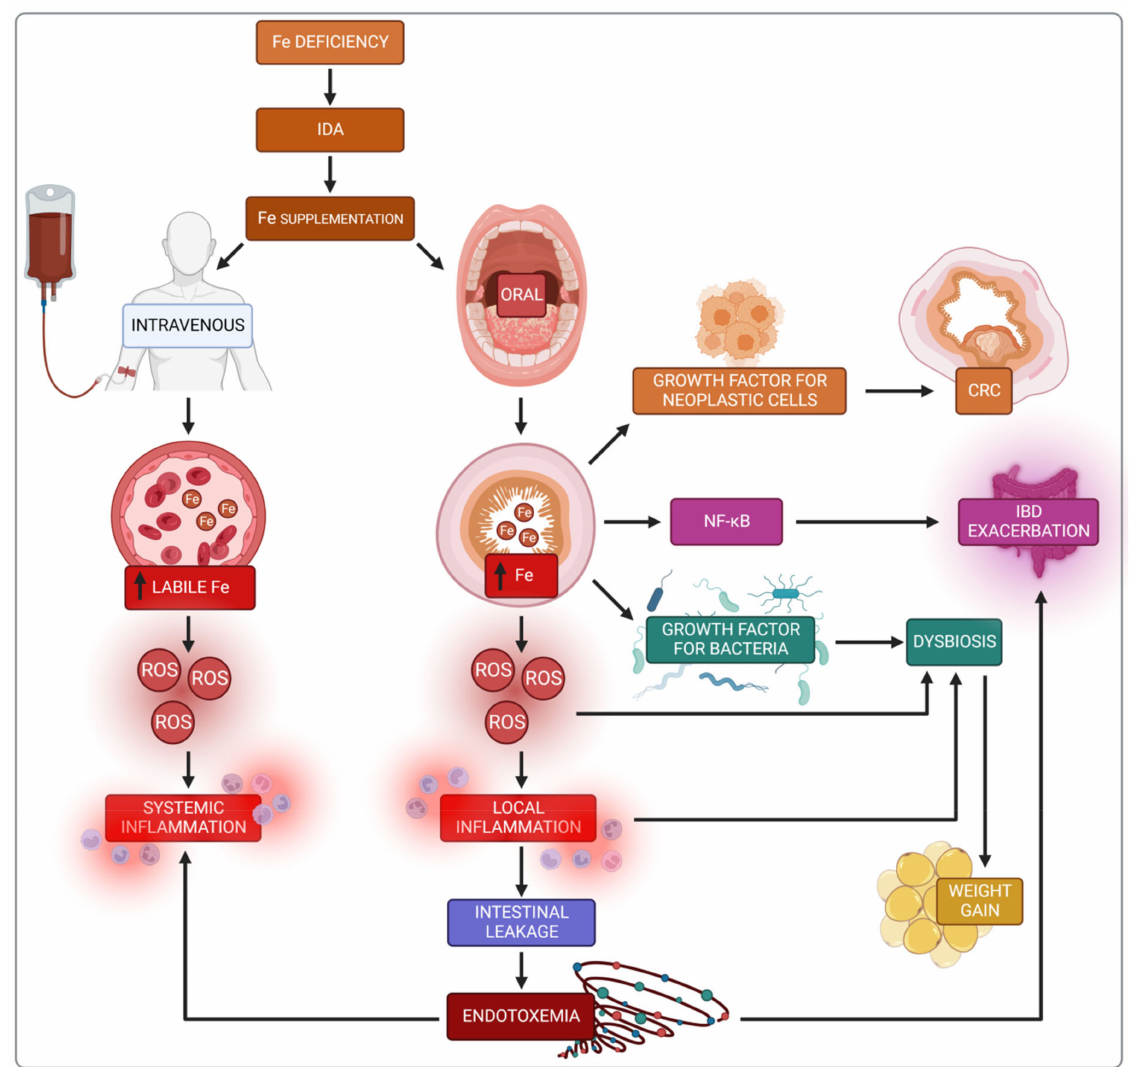
Figure 7. Impact of oral and intravenous iron supplementation on development and course in chosen clinical conditions. IDA—iron deficiency anemia; CRC—colorectal cancer; IBD—inflammatory bowel disease; NF-k β —nuclear factor kappa-light-chain-enhancer of activated B cells; ROS reactive oxygen